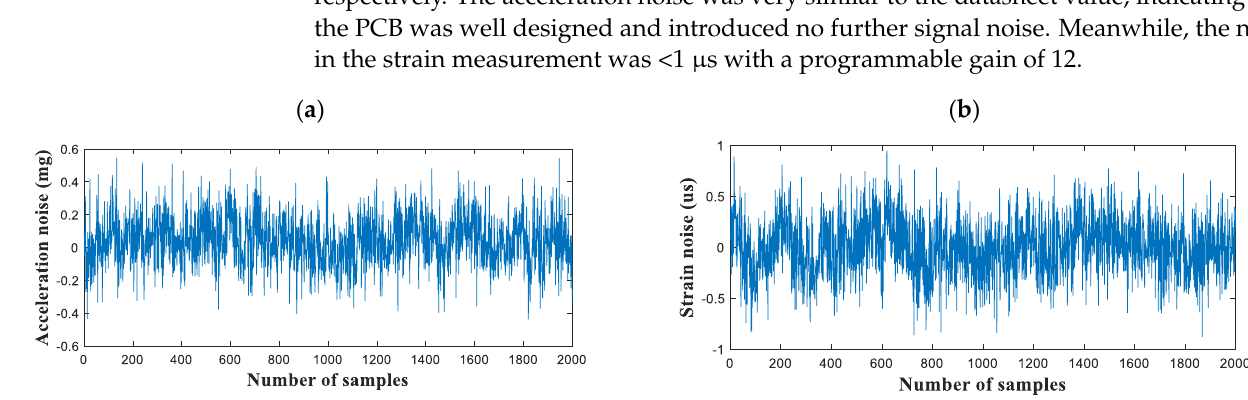
Figure 5. Noise level of the developed multimetric board: ( a ) acceleration and ( b ) strain.